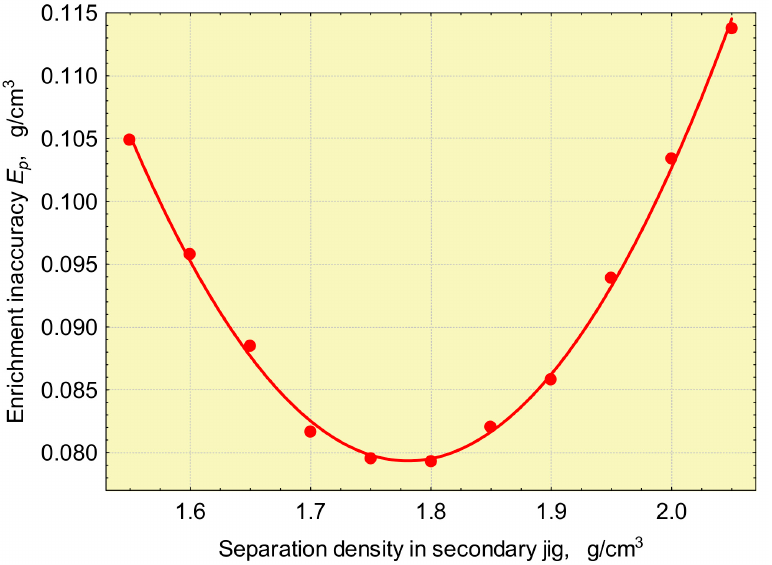
Figure 7. Enrichment inaccuracy in a system of two two-product jigs with secondary enrichment of an intermediate concentrate at different separation densities in a secondary jig.